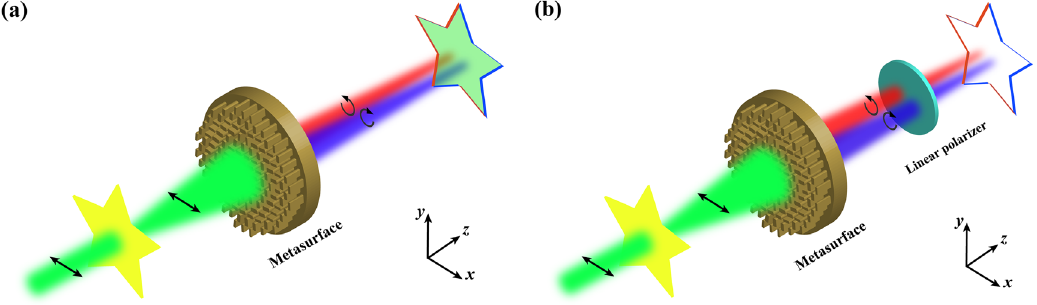
Figure 1: Schematic of the proposed monolithic metasurface. (a)The monolithicmetasurfaceforleft-handedcircularlypolarized(LCP) andright-handedcircularlypolarized(RCP)imagingwithanopposite shift along the phase gradient direction ( x -axis in this fi gure). (b) A linear polarizer is applied to eliminate the LP image of the overlapped LCP and RCP images for edge